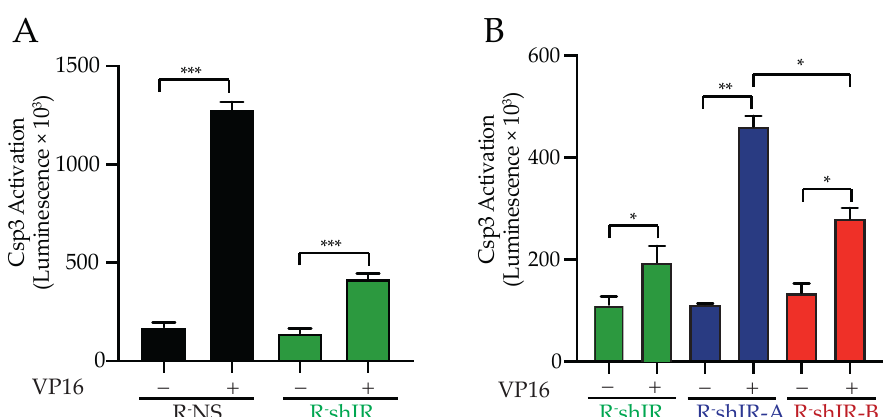
Figure 4. Insulin-unbound IR-A and IR-B differently affect the Caspase 3 activation after VP-16- induced DNA double-strand break. In ( A ) Caspase-3 activation was measured before and after exposure of the indicated cells to VP-16 7.7 µ M (IC50 R-shIR) for 48 h, while in ( B ) cells were exposed to VP-16 45 µ M (IC50 R-shIR) for 24 h (See Figure 3). Histograms indicate the luminescence value of cleaved caspase-3 and bars indicate the standard deviation obtained from three independent experiments. GraphPad Prism software version 8.0 was used to perform two-tailed t-test with 95% of confidence intervals (* p < 0.05, ** p < 0.01, *** p < 0.001) between two specific